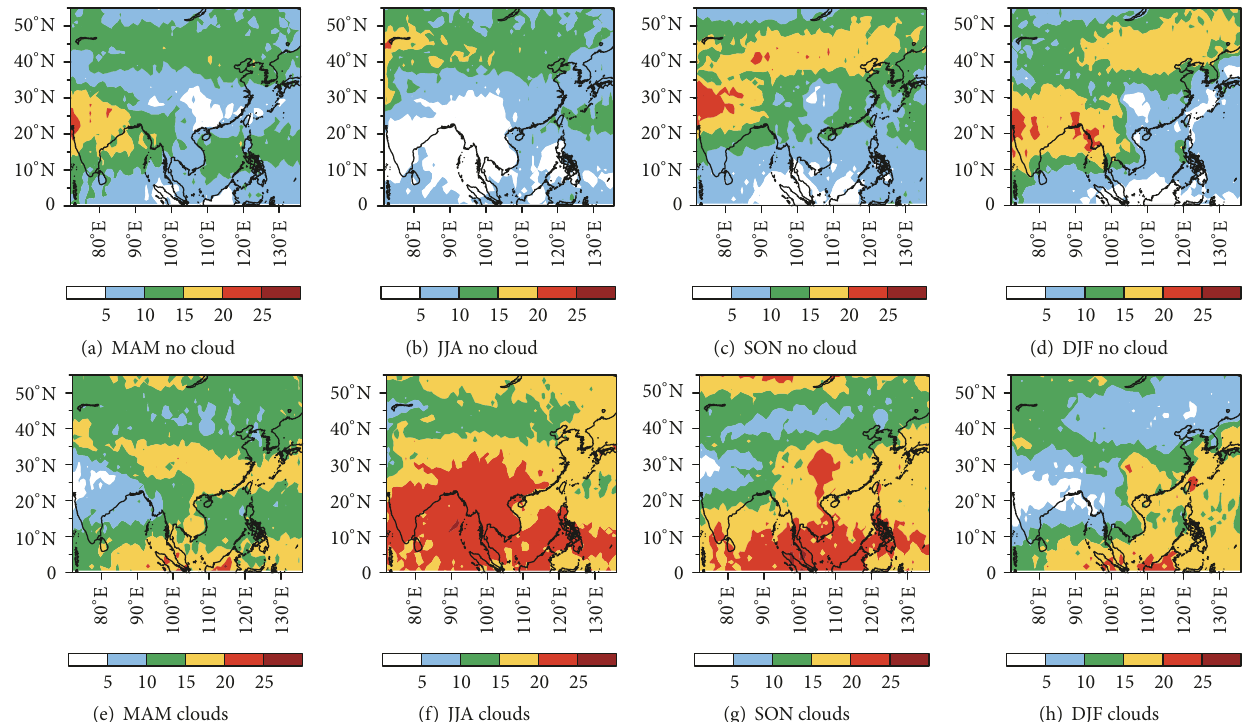
Figure 6: Horizontal distribution of cloud-free and cloudy sky occurrence in different seasons (MAM, JJA, SON, and DJF), %.